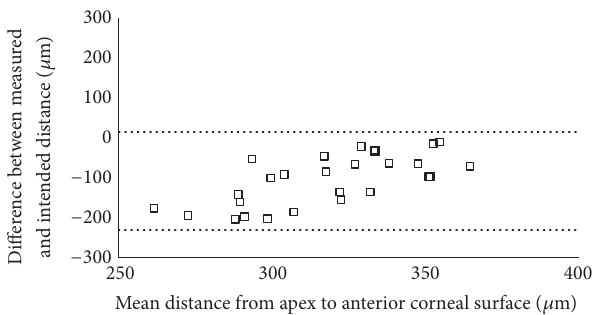
Figure 5: Scatterplot showing the differences between the measured and the intended distance from the Keraring apex to the anterior corneal surface. Individual differences between the measured and the intended distance are plotted against the mean value of the measured and the intended distance. The 95% LoA interval is represented with dotted lines.